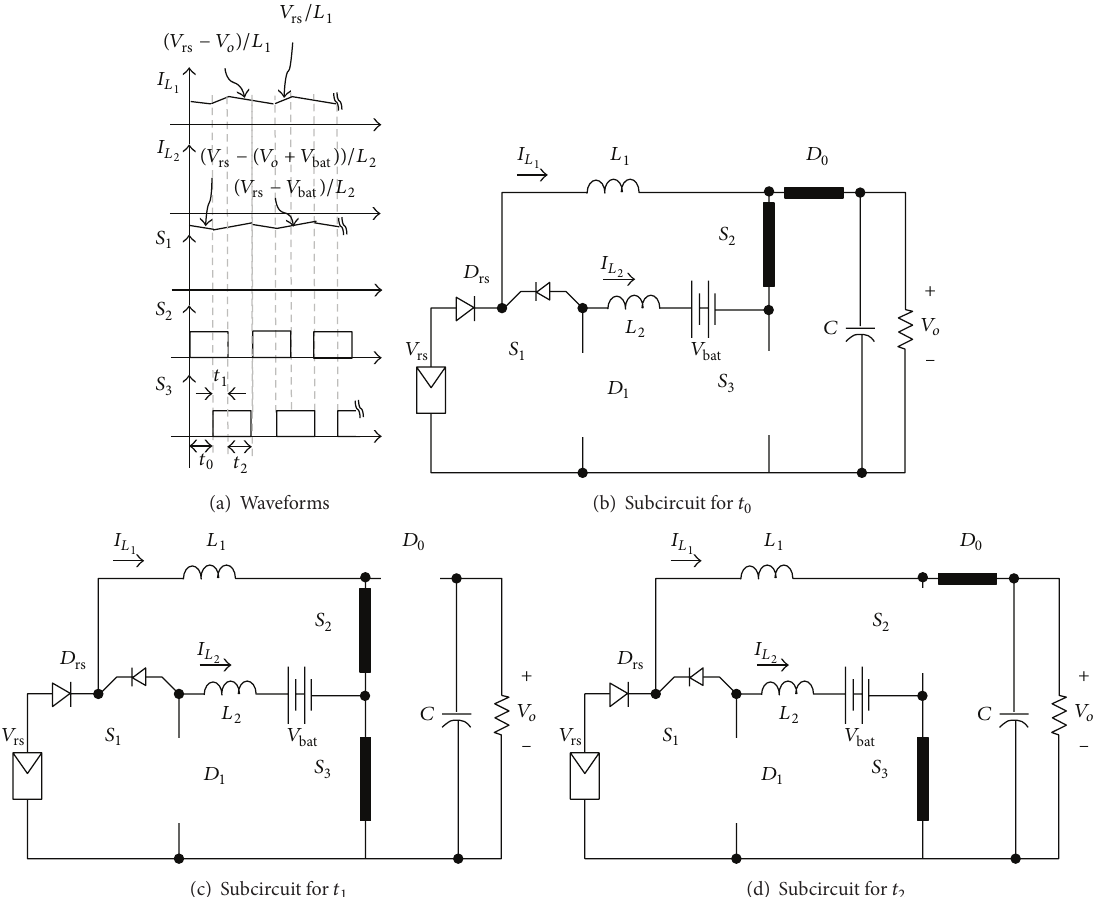
Figure 8: Waveforms and subcircuits when the energy is obtained from both sources (mode 2, energy available from renewable